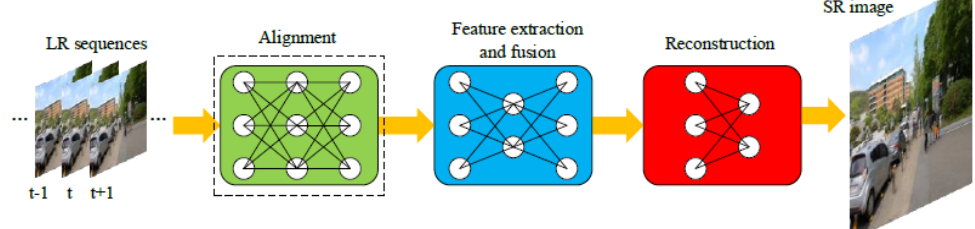
Figure 1. The general flowchart of deep learning methods for DL-MISR. (Liu et al.,